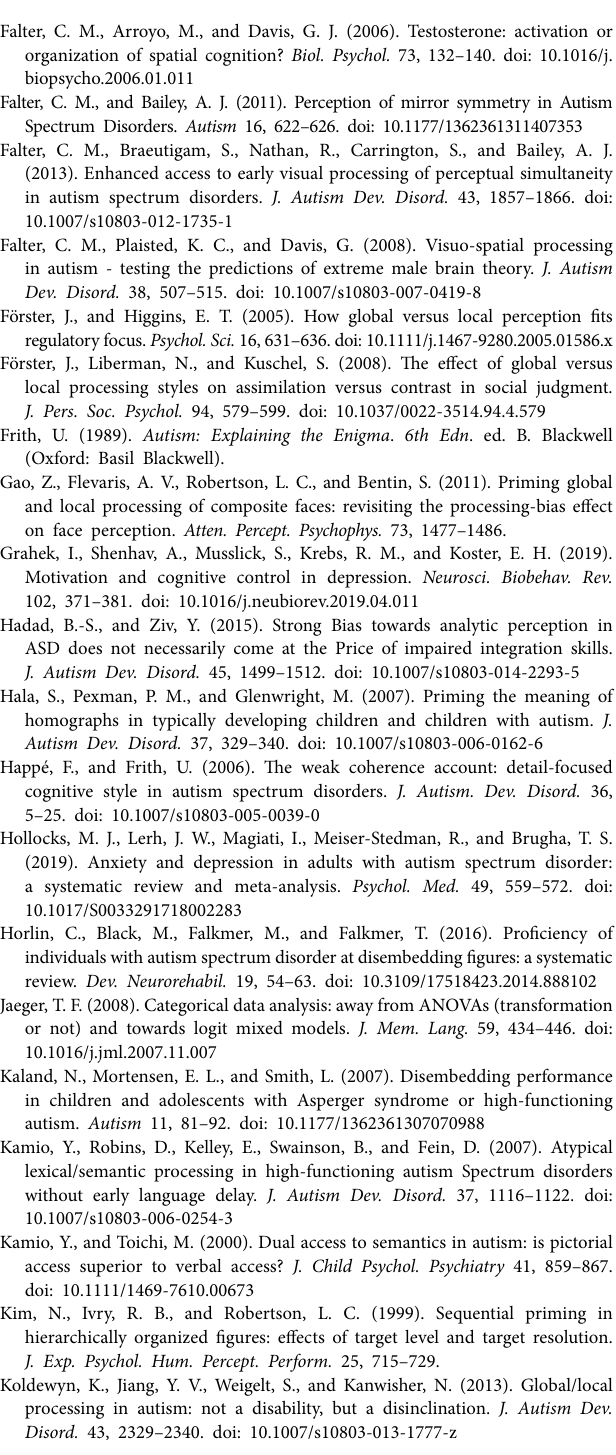
Figure-Disembedding in Autistic and Non-autistic